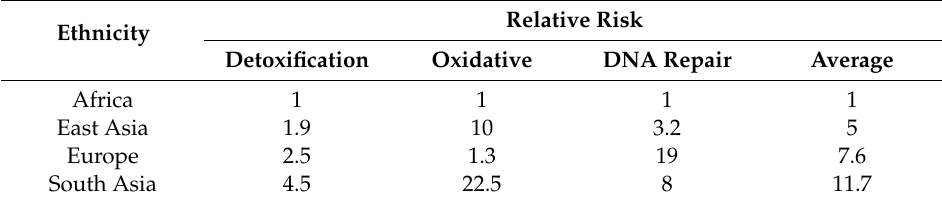
Table 2. Relative risk of unfavorable SNP in the three groups of genes, detoxification, oxidative stress an DNA repair, for the four ethnicity groups. A cumulative risk, relative to the three groups of genes is also reported. Relative Risk Ethnicity Detoxification Oxidative DNA Repair Average